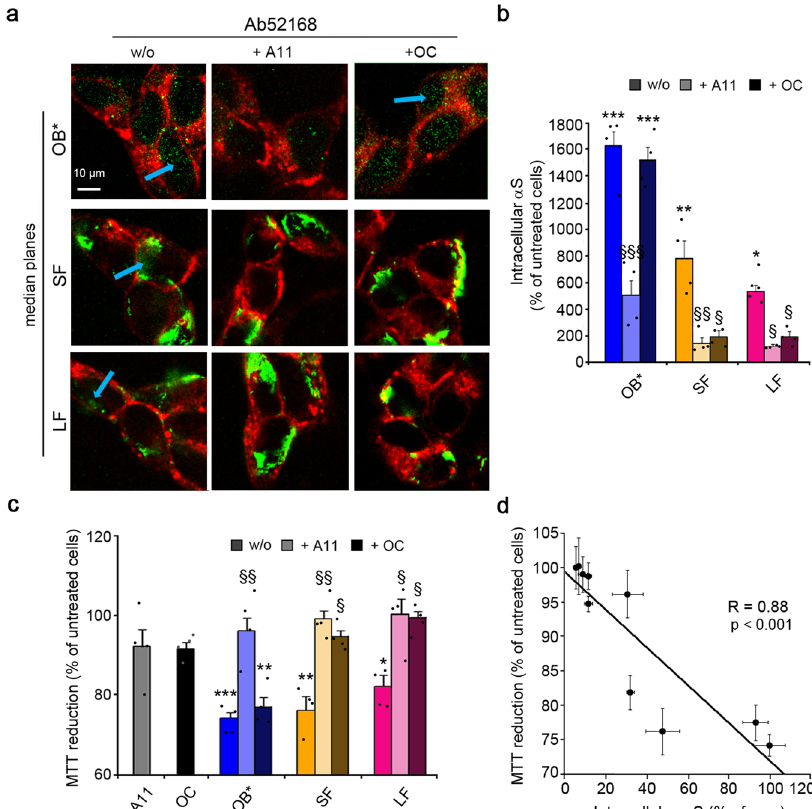
Fig. 6 Inhibition of oligomer release from fi brils prevents their toxicity. a Representative confocal scanning microscope images showing the median sections of SH-SY5Y cells treated for 24h with the indicated α S species at 0.3 μ M, in the absence or presence of A11 (AHB0052, Thermo Fisher Scienti fi c) and OC (AB2286, Sigma-Aldrich) antibodies at 1:2.5 molar ratio. Red and green fl uorescence indicates the cell membranes and the α S species revealed with WGA and polyclonal anti- α S antibodies (ab52168, Abcam), respectively. The arrows in the images show the intracellular green- fl uorescent punctae. b Semi-quantitative analysis of the green fl uorescence signal referring to panel ( a ) and derived from intracellular α S species expressed as the percentage of untreated cells. c MTT reduction in SH-SY5Y cells treated for 24 h with the indicated α S species at 0.3 µ M in the absence or presence of A11 and OC antibodies (1:2.5 molar ratio). d Dependence of MTT reduction (values reported in panel c ) on the α S-derived fl uorescence values in cells treated with OB*/SF/LF (values from panel b ) in the absence or presence of A11 and OC antibodies (1:2.5 molar ratio). In all panels, experimental errors are S.E.M. ( n = 4 with three internal replicates). Samples were analyzed by one-way ANOVA followed by Bonferroni ’ s multiple comparison test relative to untreated cells (in panels b and c , * P < 0.05, ** P < 0.01, *** P < 0.001) and cells treated with the α S species (in panels b and c , § P < 0.05, §§ P < 0.01, §§§ P < 0.001). In panel d , P < 0.001. A total of 200 – 250 cells ( a , b ), and 150,000 – 200,000 cells ( c ) were analyzed per